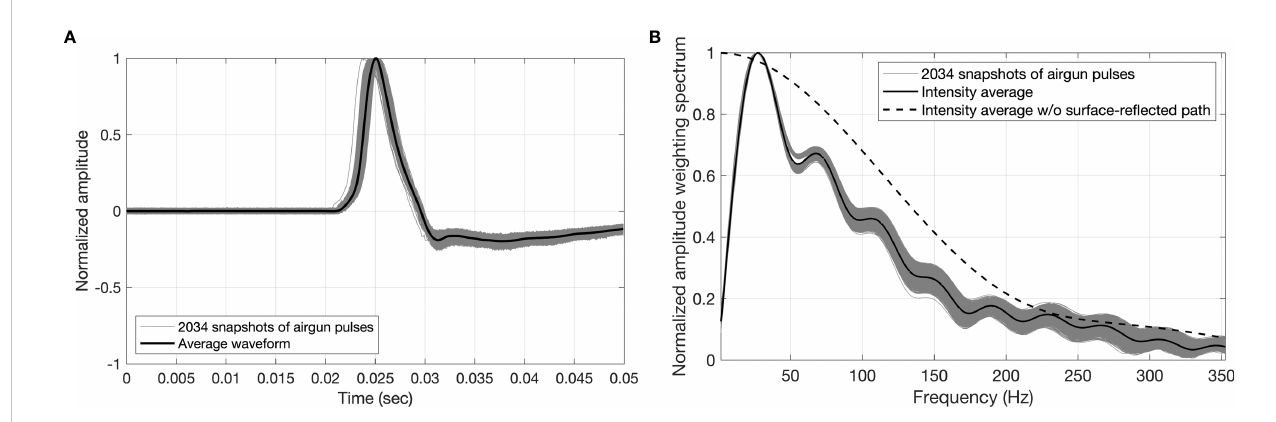
FIGURE 3 (A) Normalized waveforms of 2,034 airgun pulses (thin gray lines) measured at two near- fi eld hydrophones and their ensemble average (thick black line). (B) Their normalized amplitude-weighting spectra. Black solid and dashed lines represent intensity average curves calculated with and without a surface- re fl ected path,